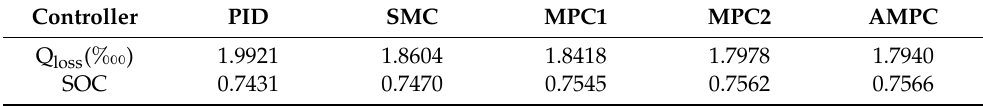
Figure 18. Under NEDC working conditions, the battery (SOHini = 1) parameters under the action of each controller: ( a ) battery capacity loss ( b ) SOC. Table 10. Capacity loss value and SOC of the battery under each controller after the NEDC (SOHini = 1).